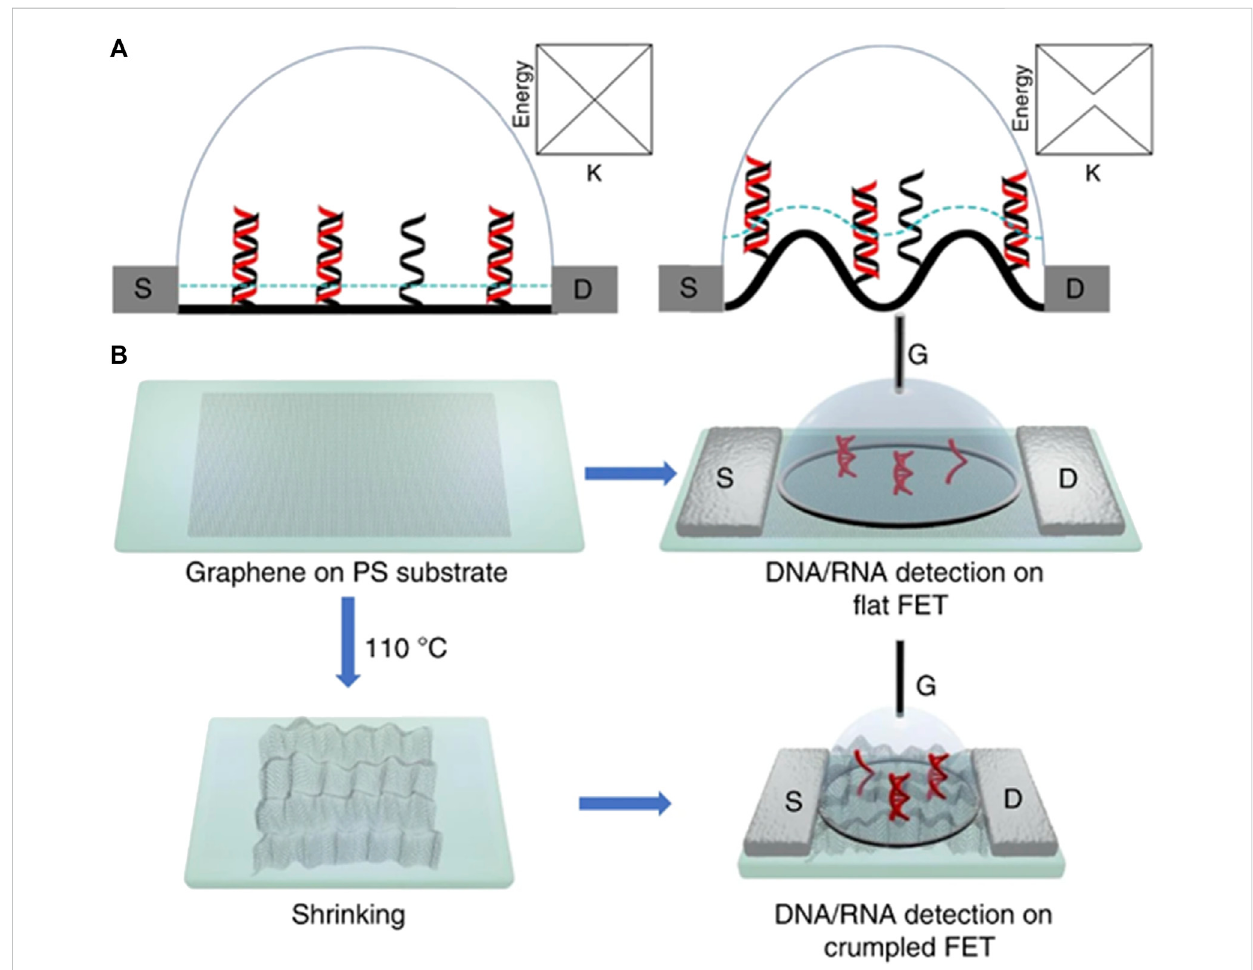
FIGURE 11 (A) Scheme of fl at and crumpled graphene FET biosensor using single and double DNA strands over graphene surface. (B) Experimental route for fabrication and fl ow proces.